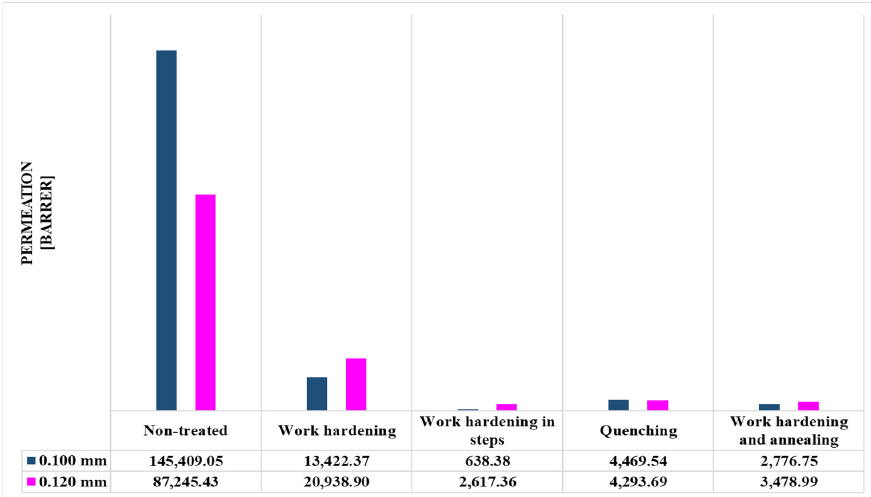
Figure 12. Permeation values (in barrer units) of metal membranes.